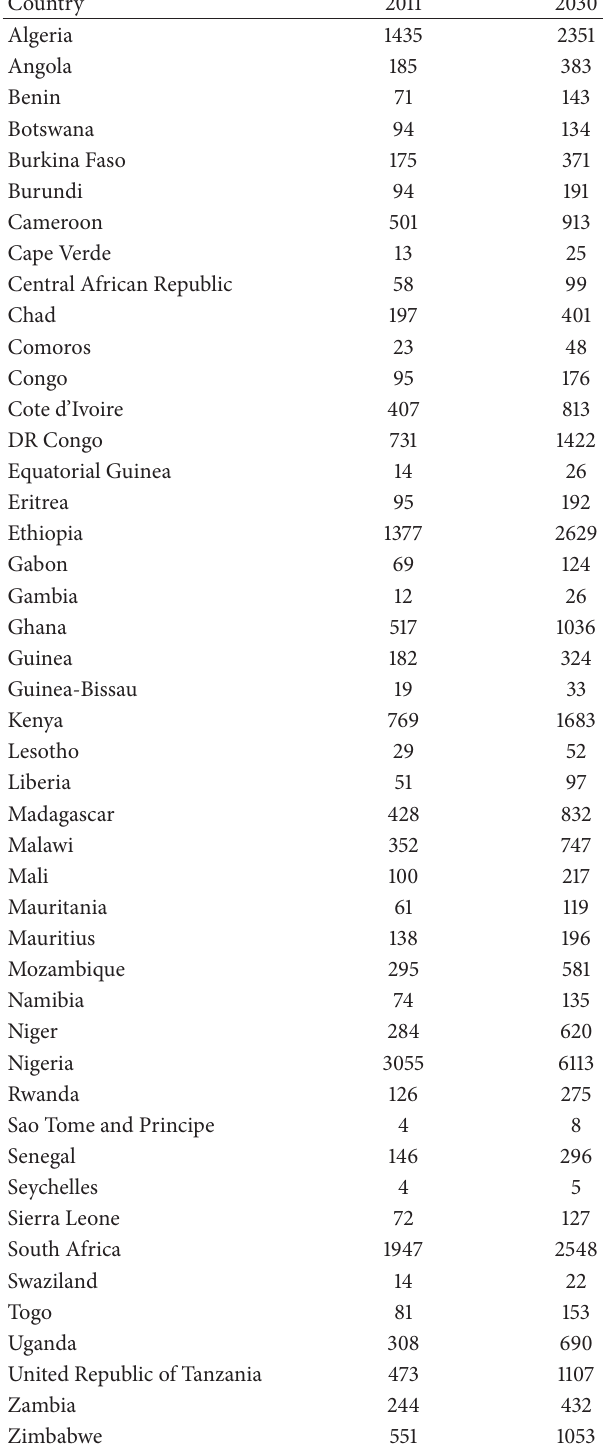
Table 2: Number of people with diabetes (in thousands) in the